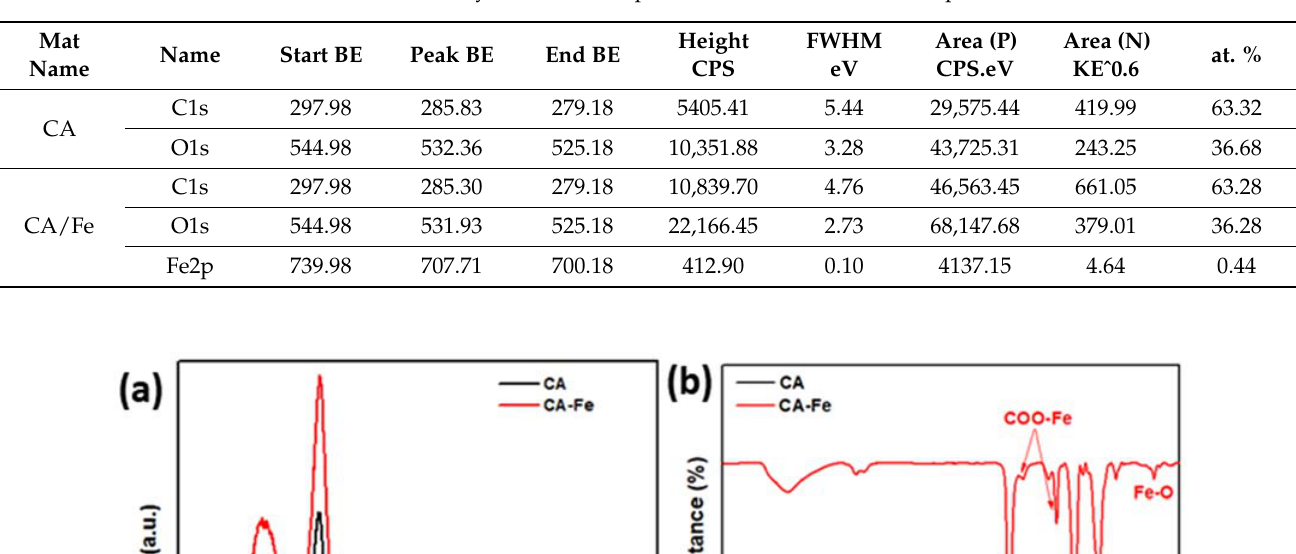
Table 1. XPS data analysis of different peaks from the different developed mats.